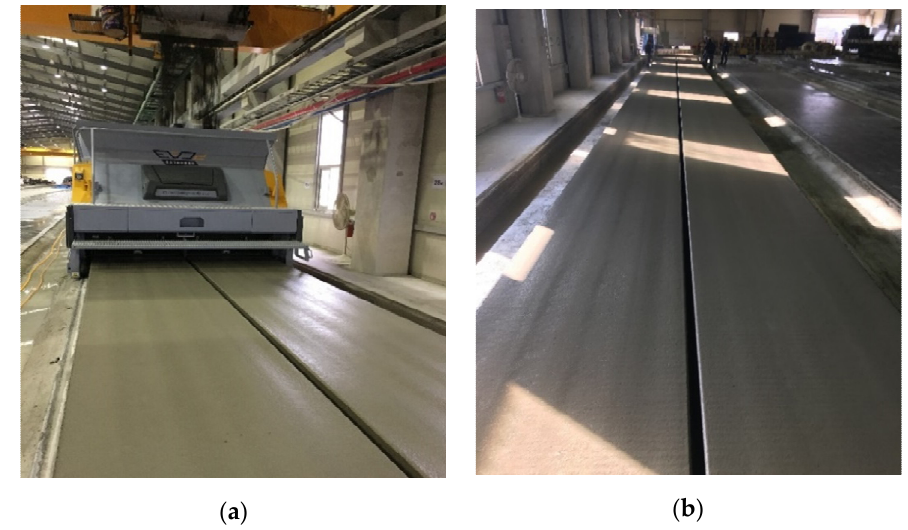
Figure 1. Extrusion method of hollow core slabs (HCS): ( a ) Casting by extrusion machine; ( b ) Extruded HCS.